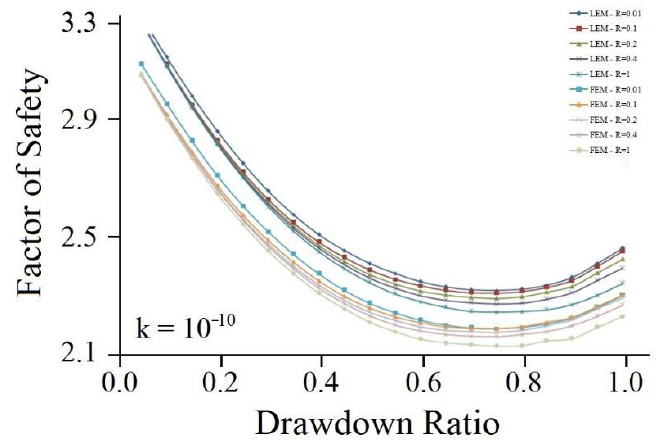
Figure 10. The F.S vs. drawdown ratio in deep sliding surface based on LEM/FEM models.